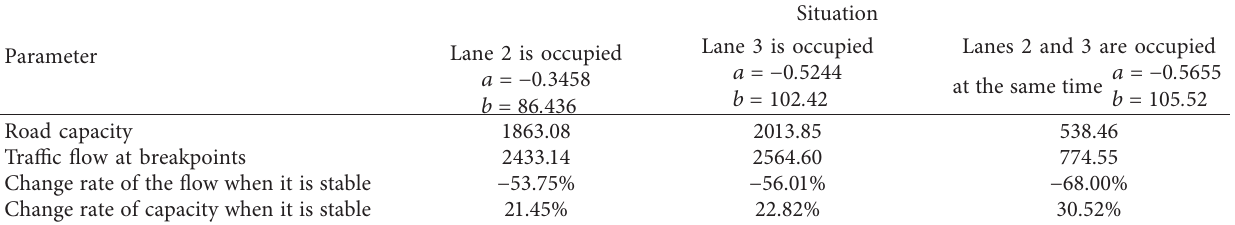
Table 2: Calculation of system evolution parameters under occasional congestion.